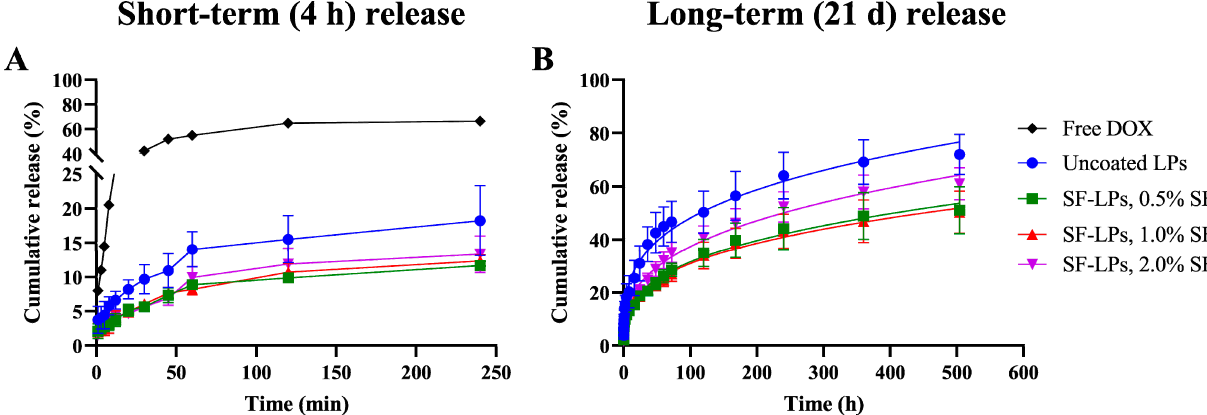
Figure 7. Comparison of in vitro release of DOX from uncoated liposomes and SF-LPs in PBS, pH 7.4 at 37 °C, over two periods. ( A ) Short-term release over the first 4 h (240 min) of drug release. ( B ) Long-term release over 21 days (500 h). The long-term release profiles were fitted with the Korsmeyer–Peppas kinetic model, M t /M ∞ = K kp × t n , where M ∞ is the amount of drug at the equilibrium state, M t is the amount of drug released over time t , K kp is the constant incorporating structural and geometrical characteristics of the nanocarrier, and n is the diffusional exponent or drug release that determines drug release mechanism. The fitting curves demonstrate that the release behavior of DOX from uncoated liposomes and SF-LPs were governed by Fickian diffusion mechanism as a matrix system.